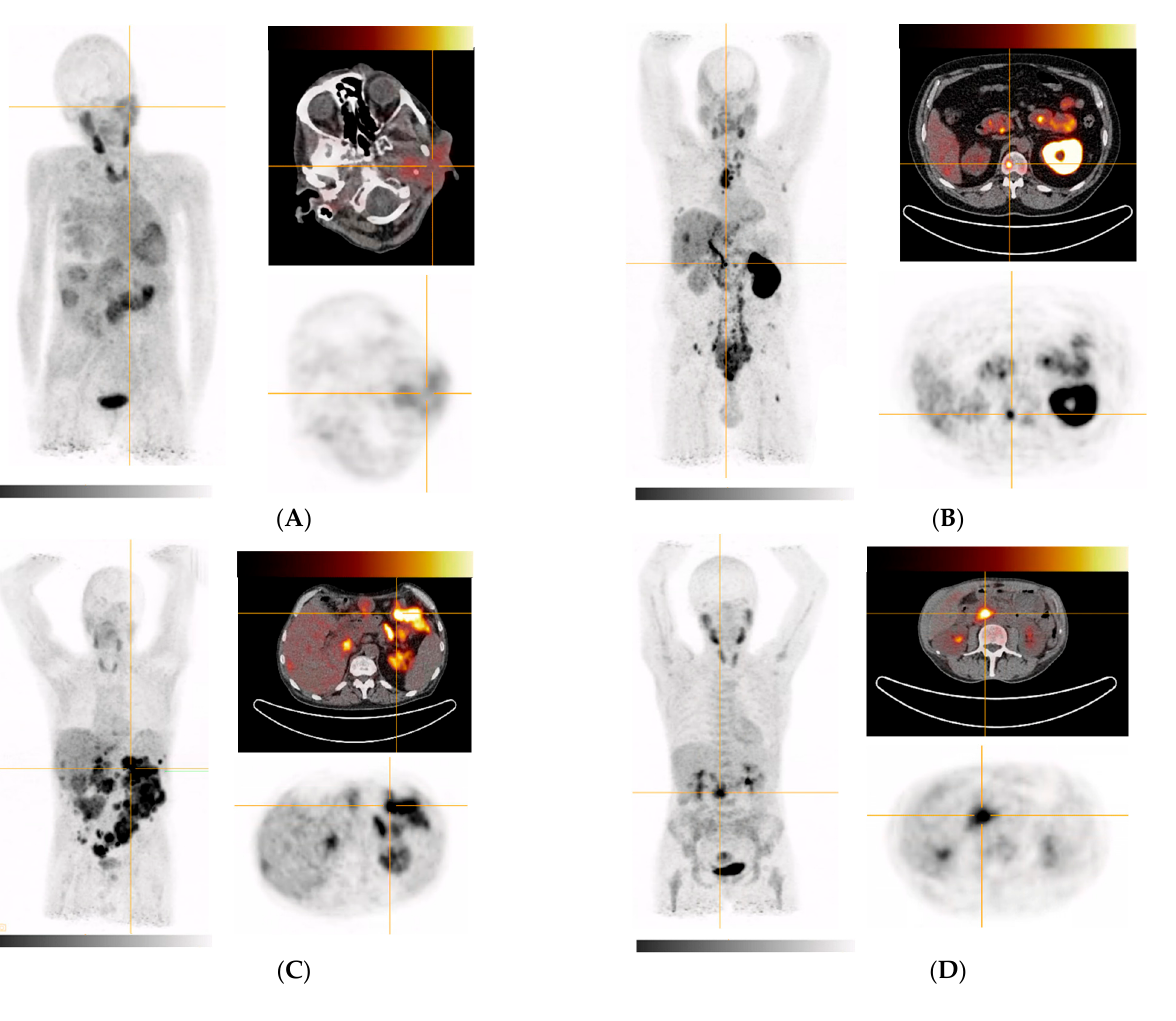
known (Figure 5B right). (Figure 5B